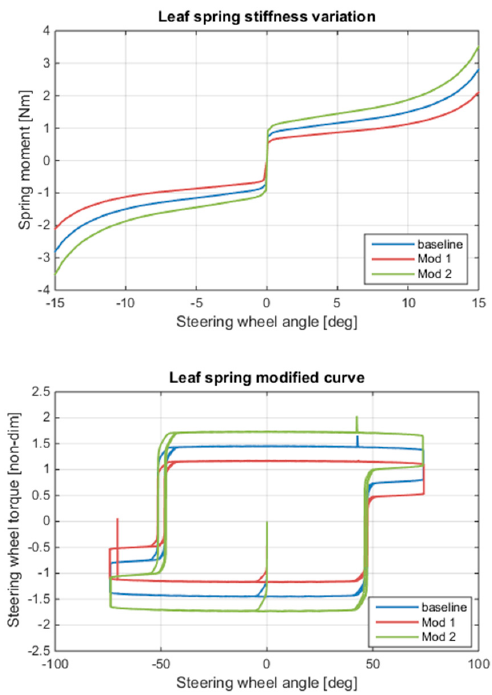
Figure 13. Different leaf spring stiffness and corresponding steering wheel torque-angle curve.